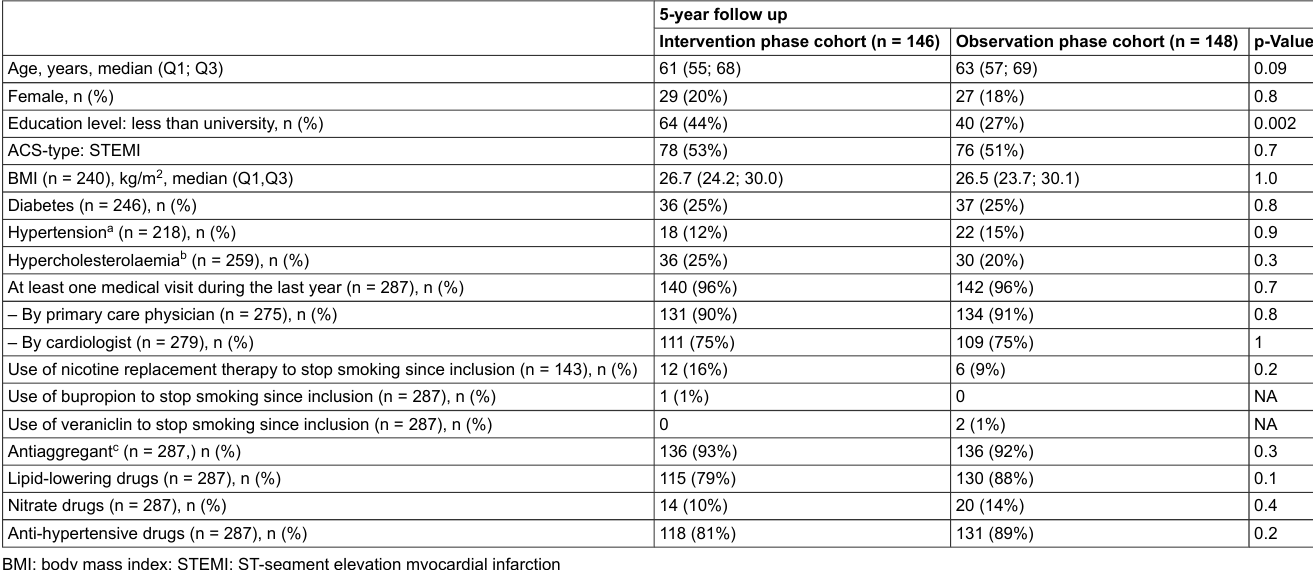
Table 1: Characteristics of patients 5 years after index acute coronary syndrome (ACS), by smoking cessation counselling phase (n = 294).